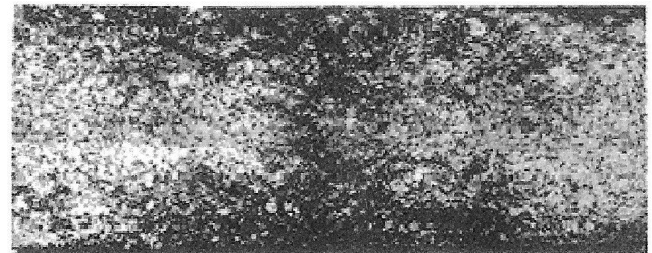
Figure 2. Etched cross-section of a laser shocked 19 mm-diameter, 3 mm-thick Fe-3Si disk showing the plastic strain distribution. 3 mm-thick quartz + 10 µm-thick lead overlays, 27 mm diameter spot, 5.64 × 10 8 GW/cm 2 , 30 ns pulse width. Reproduced with permission from [15], The Minerals, Metals & Materials Society and ASM International, 1977.